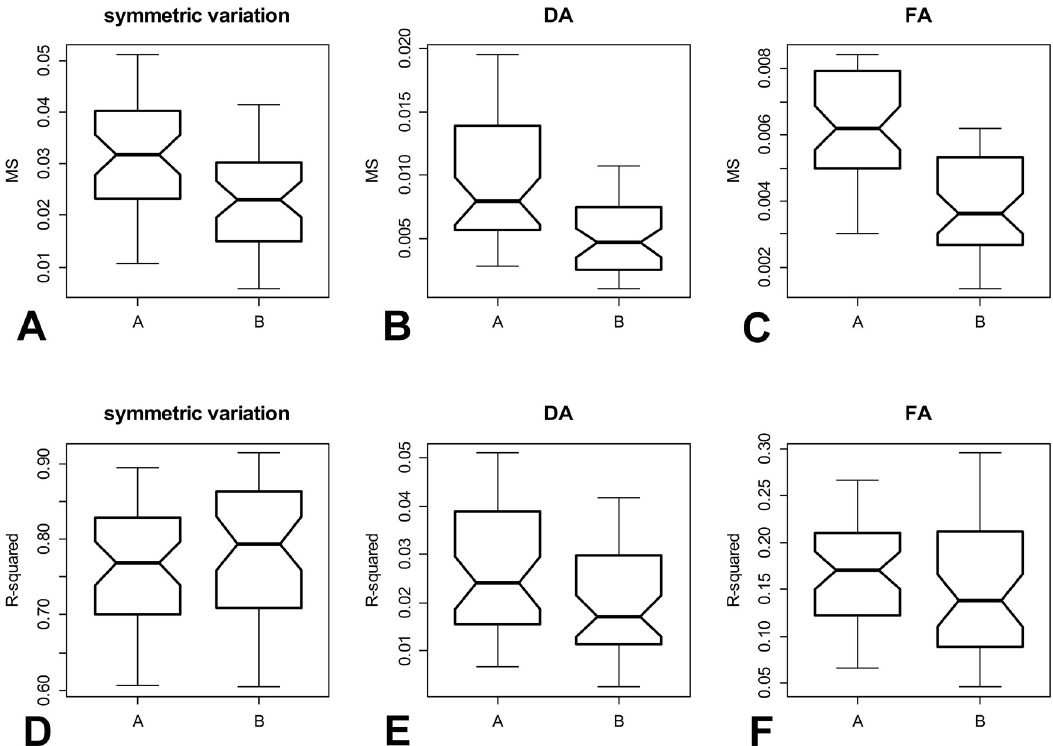
Fig 4. Comparison of the MS and R 2 values yielded by the Procrustes ANOVA models of shape variation within plants at both populations. (A) MS values for symmetric variation depicting the differences in shape among the segments. (B) MS values for variation spanned by directional asymmetry. (C) MS values for fluctuating asymmetry. (D) R 2 values for symmetric variation. (E) R 2 values for directional asymmetry. (F) R 2 values for fluctuating asymmetry.